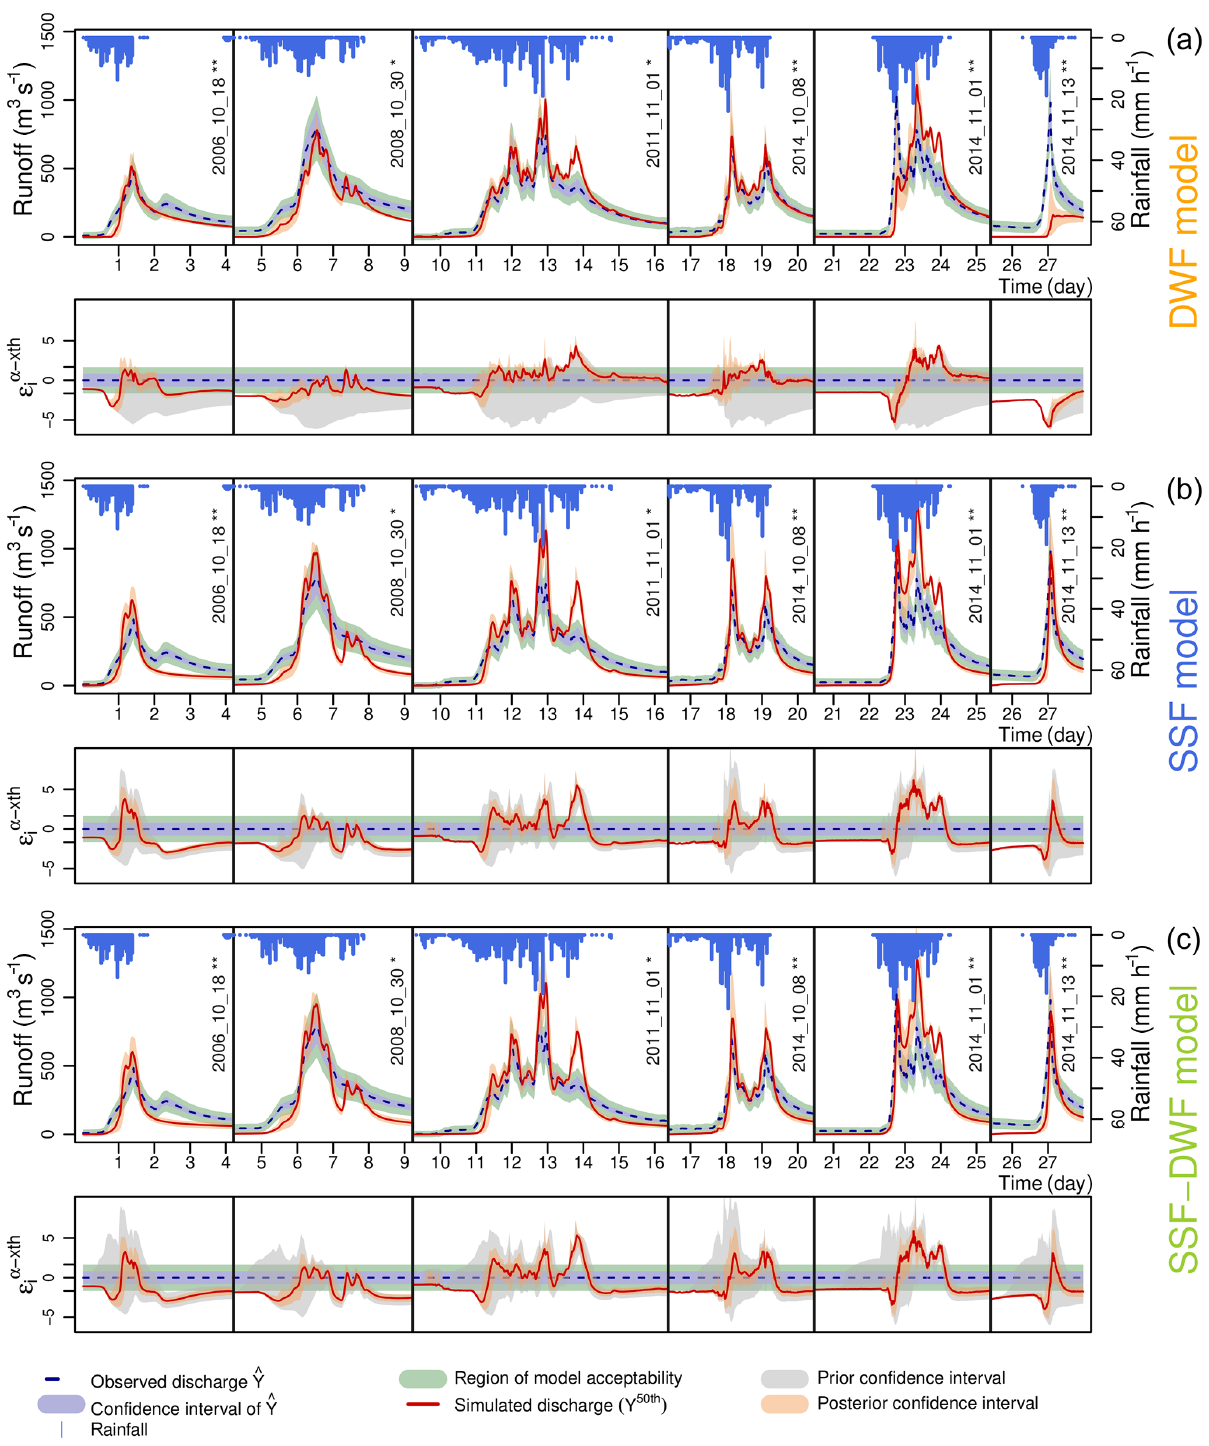
Figure 10. Calibration of the three models for the Ardèche catchment at Ucel (no. 1b). The results of the simulation of five flood hydrographs and the inherent modelling errors (Eq. 10) for each model ( a : DWF, b : SSF and c : SSF-DWF). The median simulation and the posterior confidence interval are shown in red and salmon, respectively. The confidence intervals of the measured flows and the acceptability zone are shown in green and blue, respectively. The a priori confidence intervals for each model (i.e. with no calibration) are shown in grey. Denoted are events of calibration ( ∗ ) and events of validation ( ∗∗